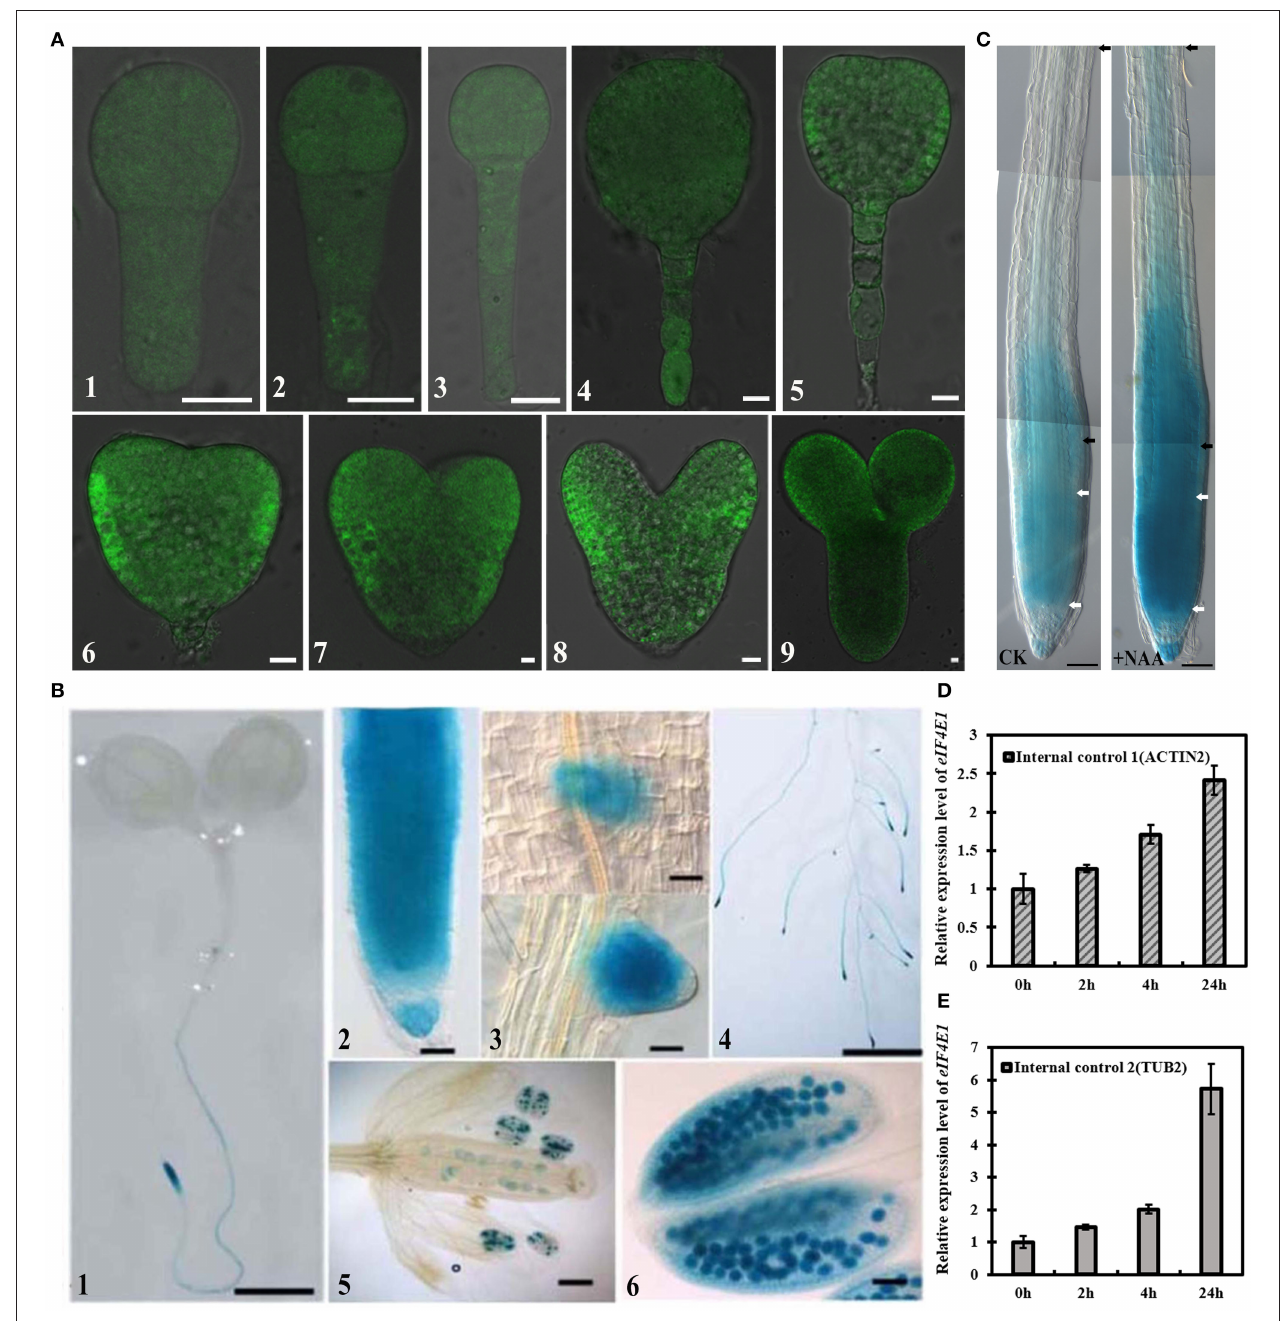
FIGURE 1 | Expression profiles of eIF4E1 in Arabidopsis . (A) eIF4E1 pro :YFP-eIF4E1 was expressed in embryos. The confocal images were merged by the DIC and the GFP channels. 8-cell (A1), 16-cell (A2), 32-cell (A3), globular (A4), triangle (A5), early heart (A6, 7), heart (A8), and mature (A9) embryo stages. (B) Detection of GUS activity in the primary roots (B1, 2) of 7-day-old eIF4E1 pro :GUS seedlings, the early stage (up panel) and the late stage (down panel) of lateral root primordia (B3), and lateral roots (B4), as well as in anthers and pollens (B5, 6). (C) Detection of GUS activity under exogenous 10 µ M NAA treatment. To display the meristem zone and entire elongation zone, (C) is generated by three field photographs (using the Photoshop6 software overlap function). The region between two white or two black arrowheads indicates the meristem or elongation zone, respectively. CK, a control without NAA treatment. (D,E) Expression level of eIF4E1 was significantly induced in 7-day-old wild-type seedlings by 10 µ M NAA treatment. Transcription levels were normalized to ACTIN 2 (D) or TUBULIN 2 (E) , respectively. Data are presented as mean values of three biological repeats. Scale bars: (A) 10 µ m; (B1–4) 2mm; (B5, 6; C) 50 µ m.